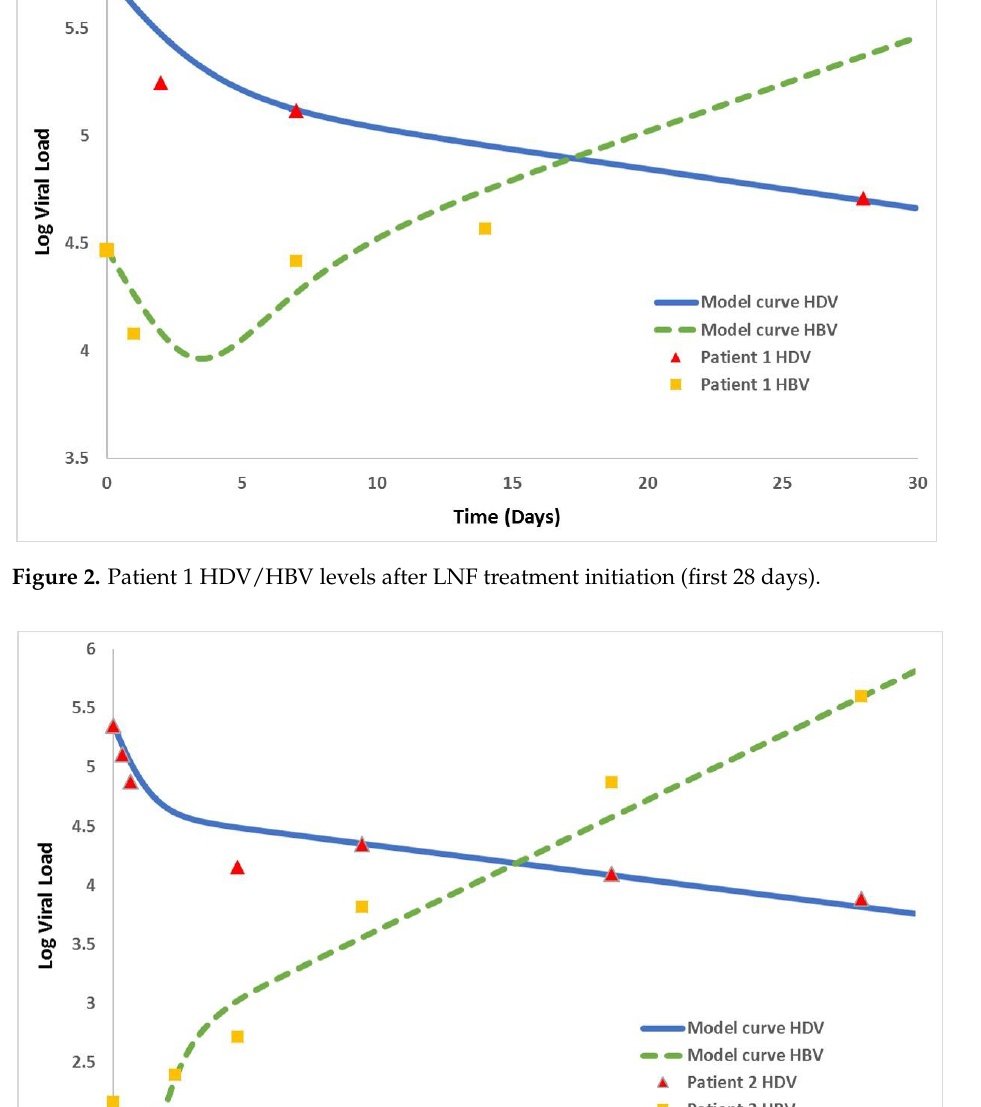
Table 4. Model parameter values for Patient 1 and Patient 2 of [7].